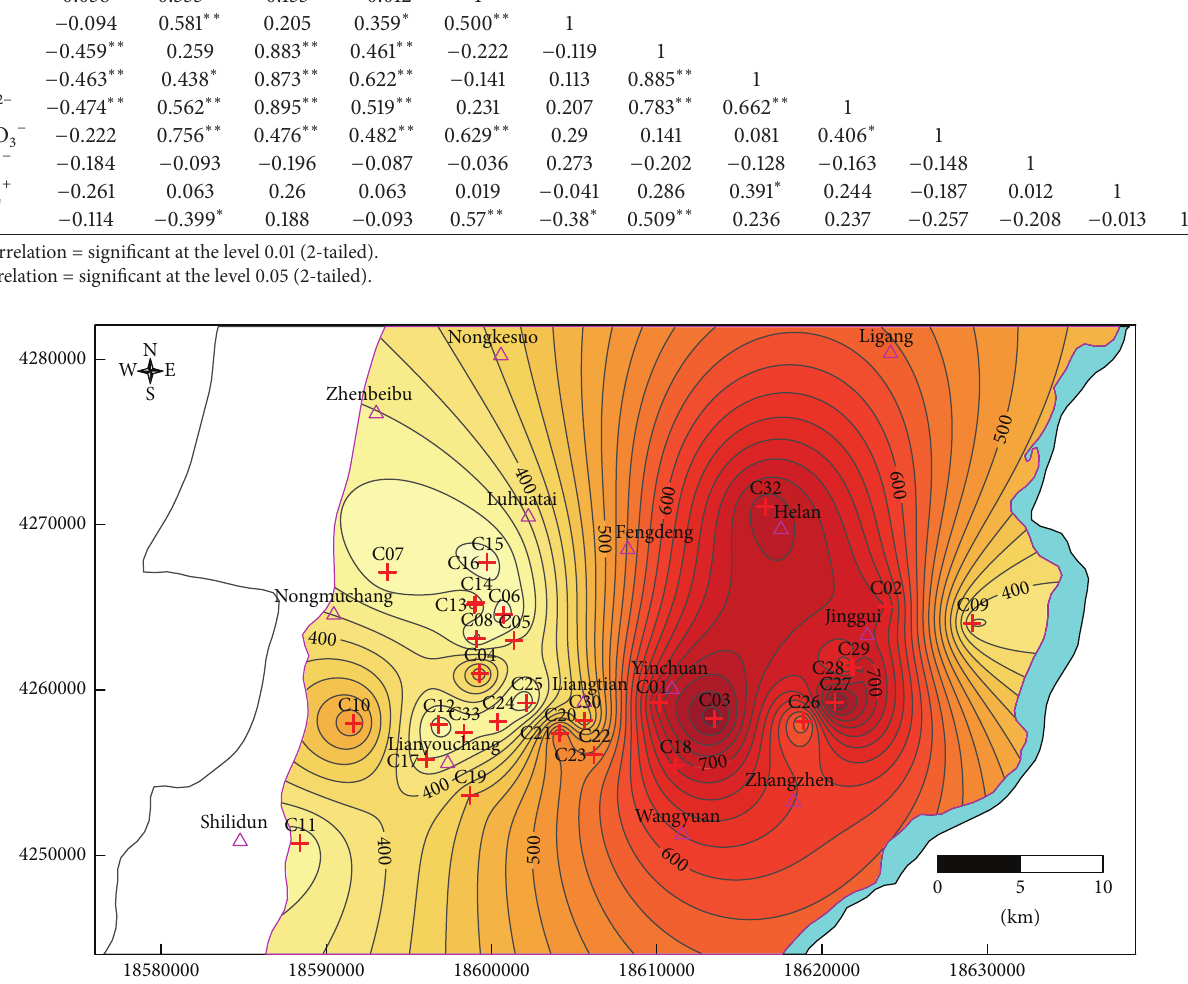
Figure 4: Spatial distribution of TDS of the study area